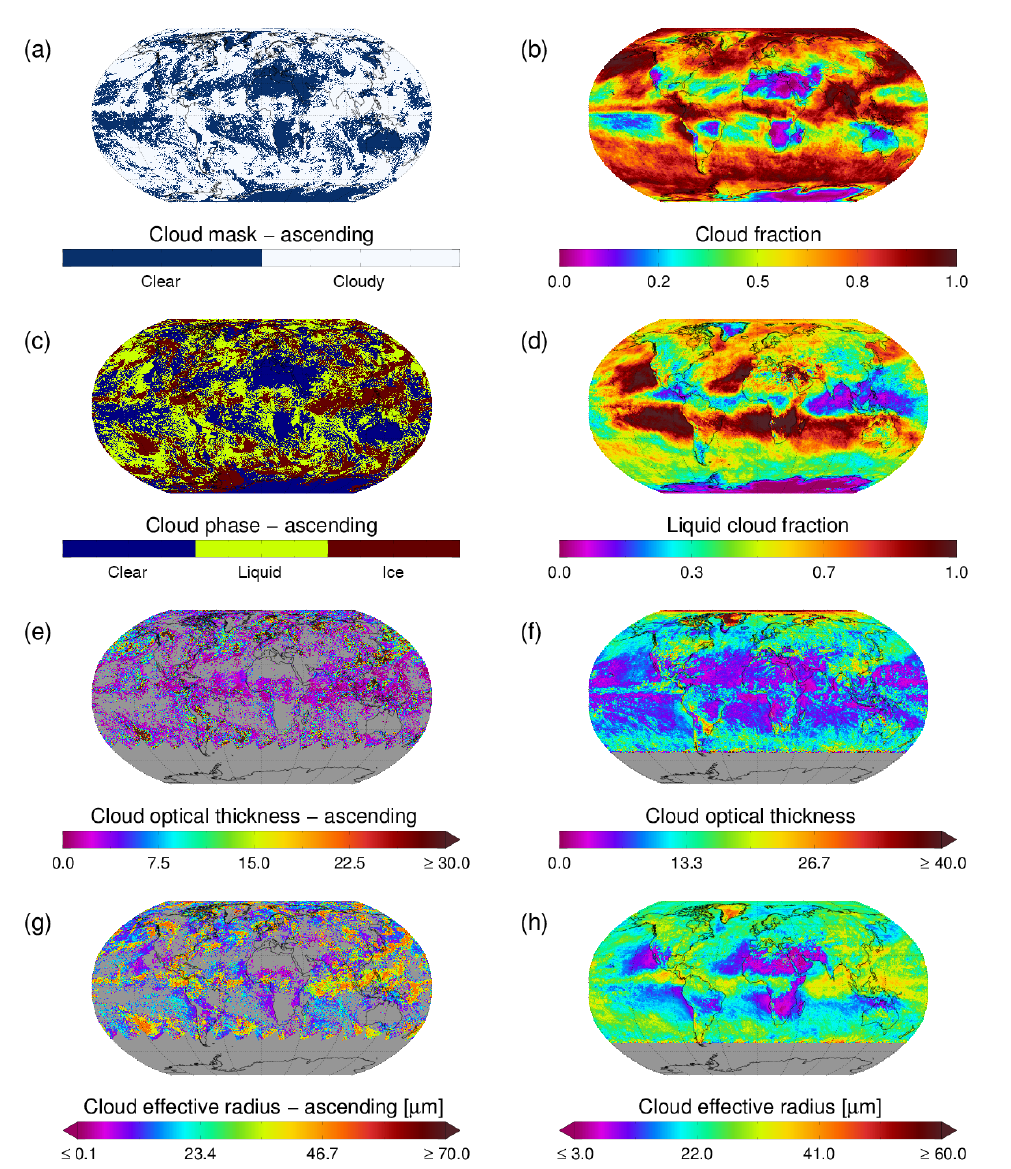
Figure 5. Level-3U (a, c, e, g) and Level-3C (b, d, f, h) of cloud mask/fraction (a–b) , cloud phase/liquid cloud fraction (c–d) , optical thickness (e–f) and effective radius (g–h) for the AVHRR-PM dataset for June 2008. For the Level-3U examples, the ascending nodes of the orbits are shown, which roughly correspond to the daylight portions of the orbits of NOAA-18. COT, LWP, IWP and CLA are only retrieved during daytime conditions. Areas with no valid retrievals in this day/month are